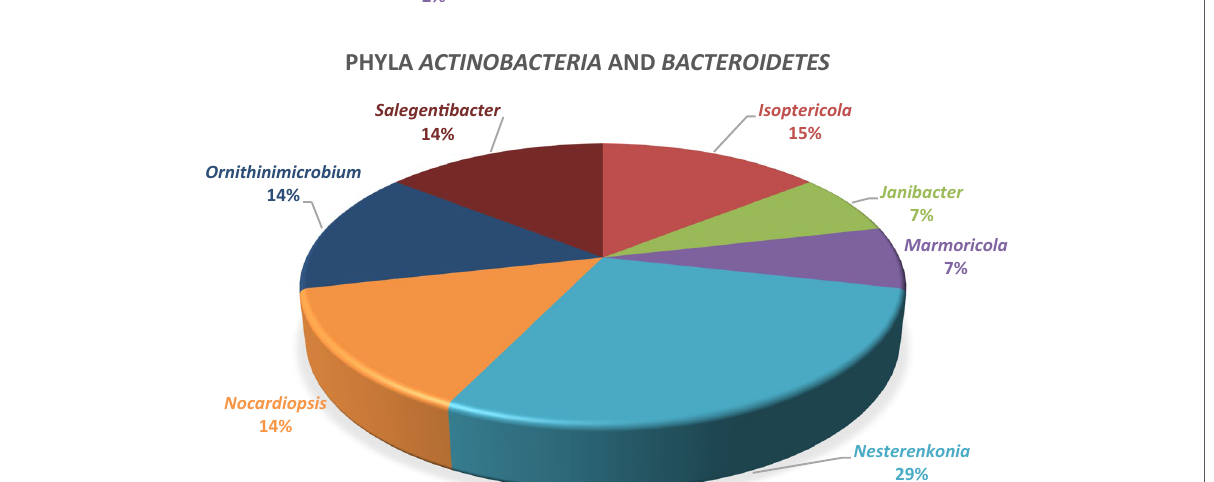
Fig. 2 Distribution of the relative abundance of the bacteria genera isolated at Zipaquirá salt